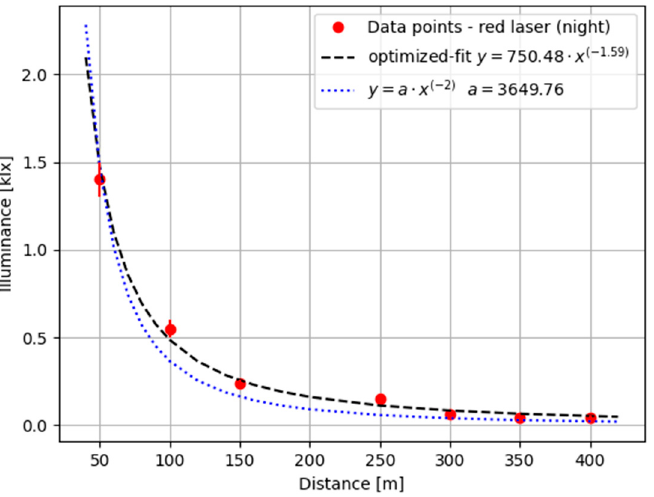
Figure 6. The dependence of the illuminance on the distance of the red laser at